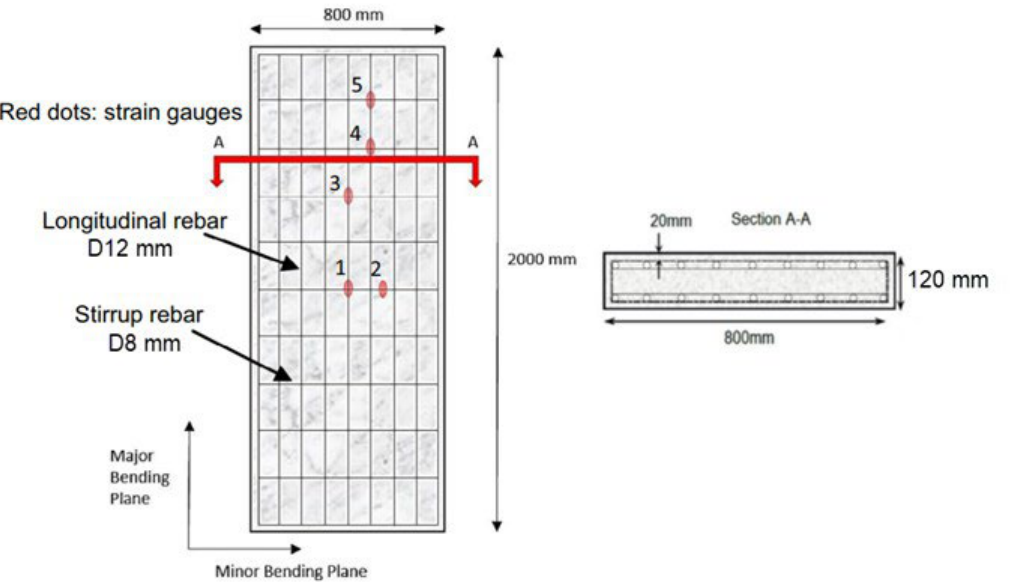
Figure 2 - Reinforcement layout of slab specimens tested by Li et al. [10]